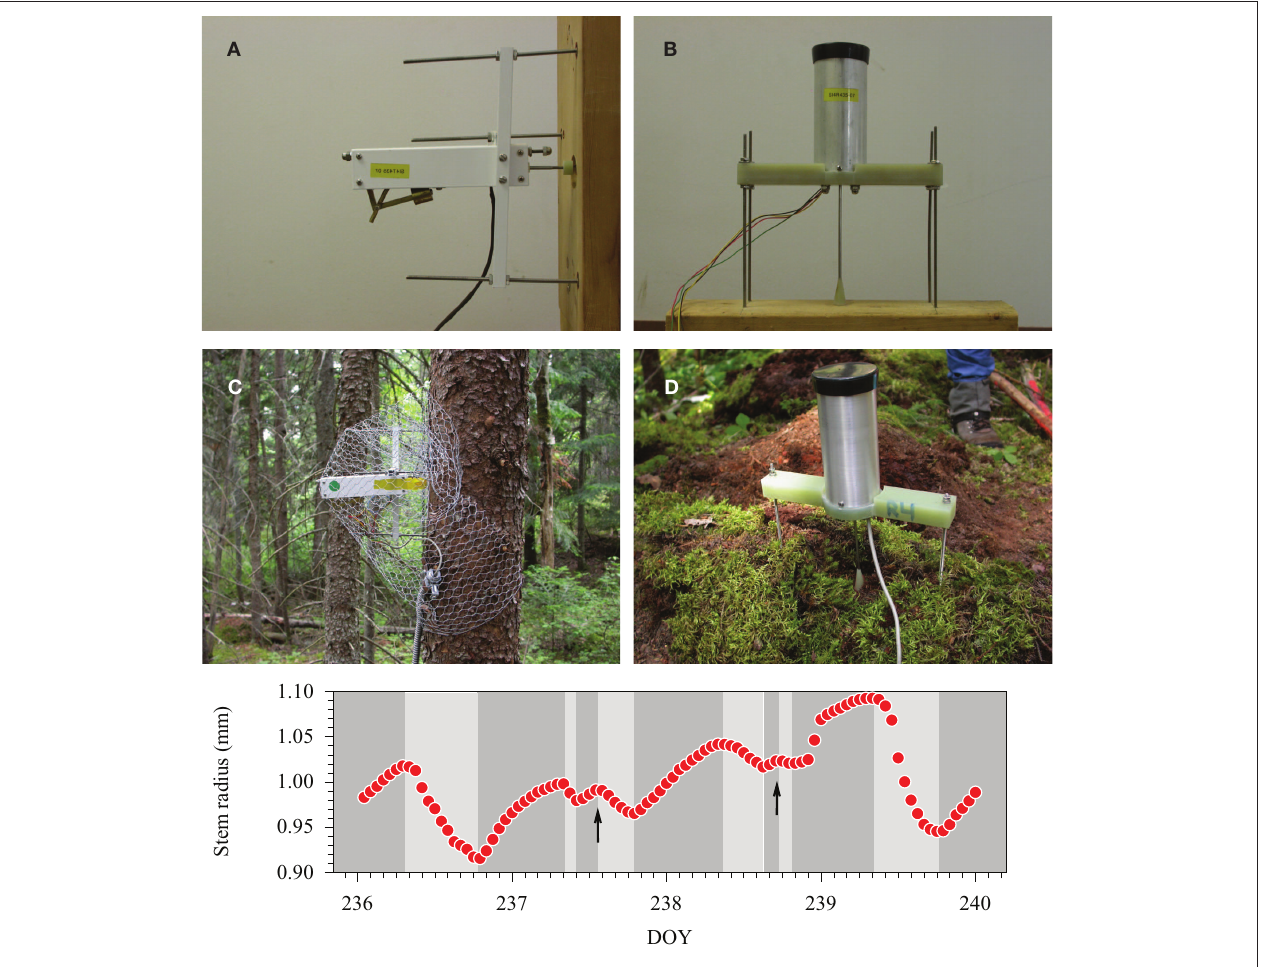
Figure 1 | Stem and root dendrometers during assemblage (A,B) and installed on the tree (C,D). Cycles of contraction (light-gray background) and expansion (dark-gray background) of radius variation detected by a high-resolution, automatic dendrometer in black spruce. Arrows indicate examples of variations deviating from the theoretical diurnal pattern. Modified from Deslauriers et